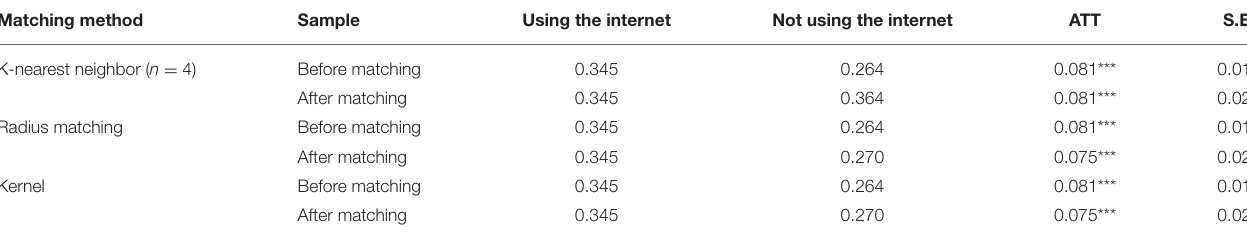
TABLE 3 | Propensity score matching (PSM) estimation for effect of Internet use on mental health.